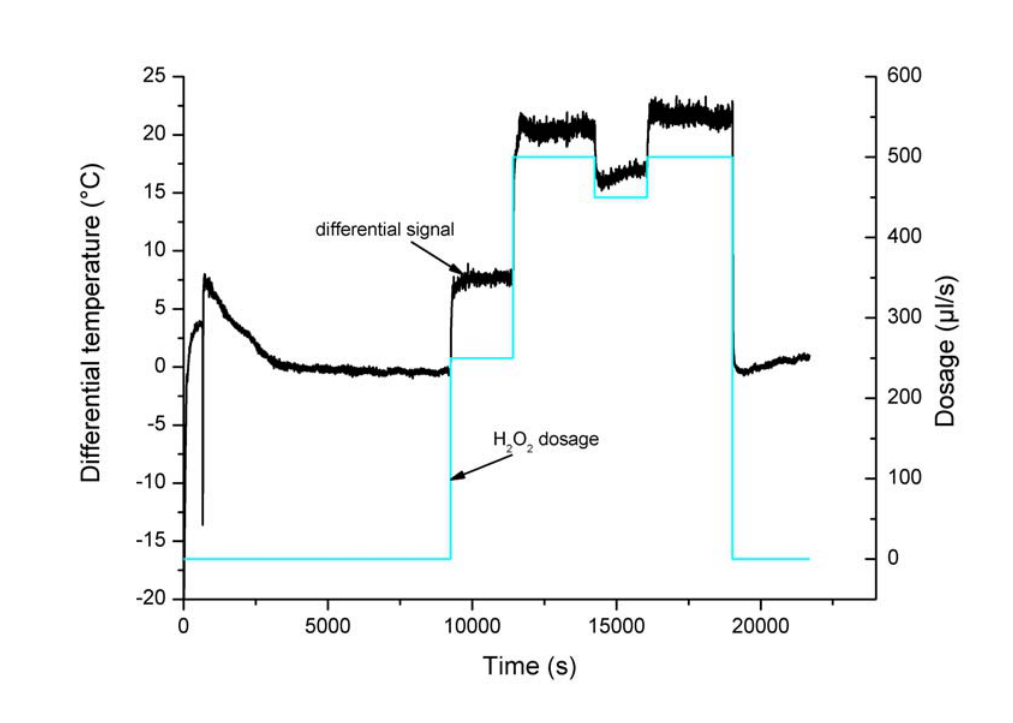
Figure 8. Difference signal of the normalised temperature of one reference sensor and the H sensitive temperature